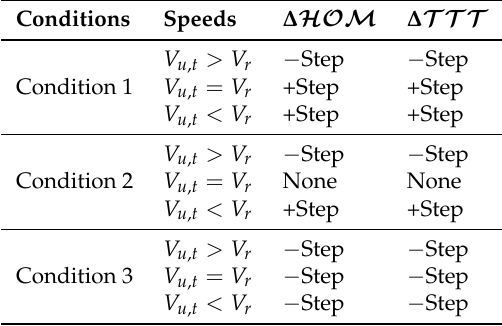
Table 2. Adjusting the table of HCPs.